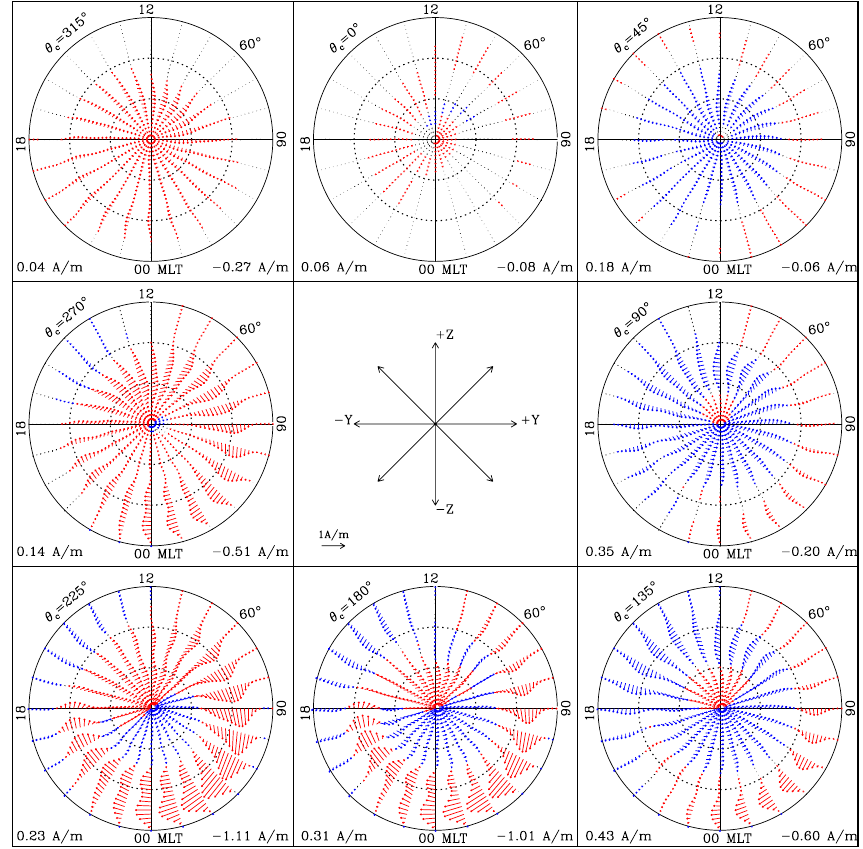
Fig. 1. Average ECS at 8 different IMF clock angles with increments of 45 ◦ . The scale length of current vector is shown at the bottom of the center box. Latitude circles are plotted at 10 ◦ intervals, the outer boundary of each plot is at 60 ◦